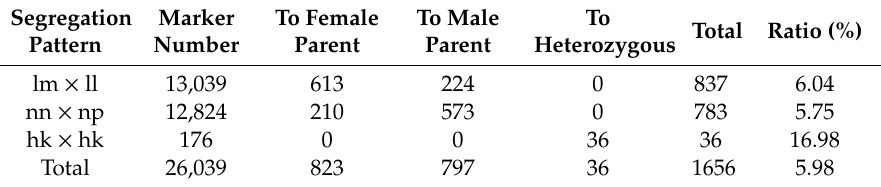
Table 3. Summary of SNP markers exhibiting segregation